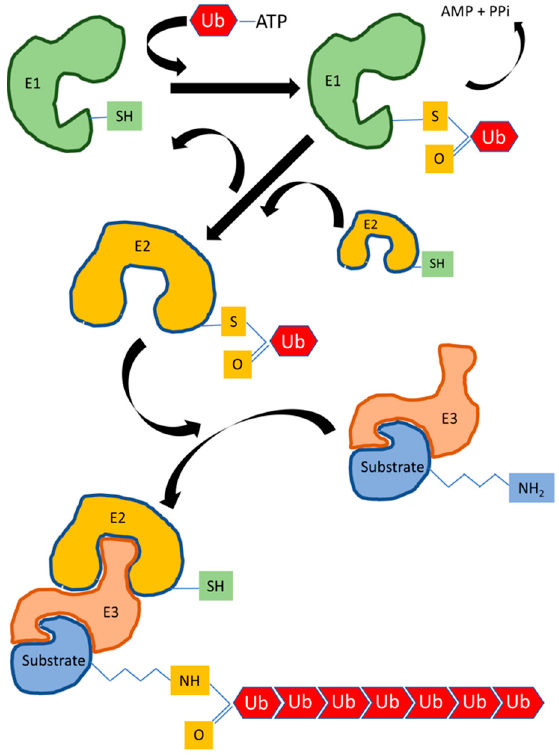
Figure 1. The sequential steps of ubiquitylation reaction. Three enzymes work sequentially in the reactions cascade of ubiquitylation: E1, the activating enzyme; E2, the conjugating enzyme; and E3, the ligase enzyme. The glycine carboxy-terminal of ubiquitin is firstly linked to a specific cysteine of the E1 enzyme by a thioester bond through ATP hydrolysis, and subsequently transferred to a cysteine of the E2 enzyme, which in turn catalyze the transfer of ubiquitin to the E3 enzyme and eventually to protein substrate.